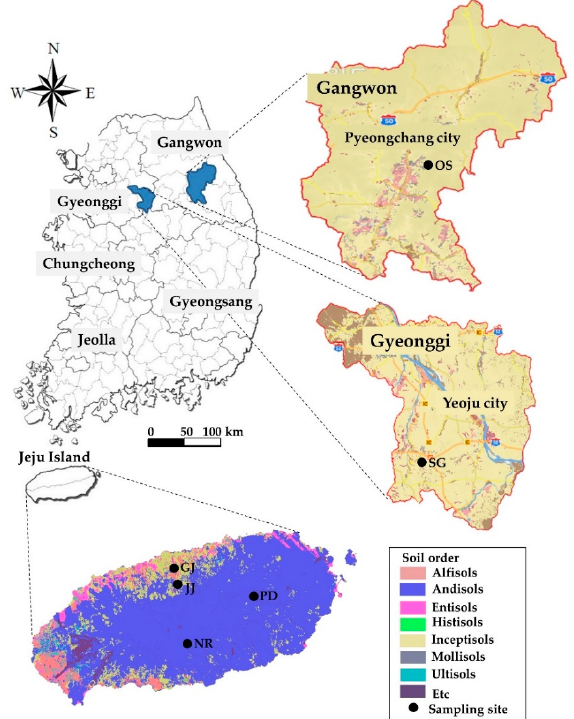
Figure 1. Map of the study area with soil sampling locations in Jeju Island [Andisols: Noro (NR) and Pyeongdae (PD), Ultisols: Jeju (JJ), Alfisols: Gangjeong (GJ)] and in Korean mainland forest soils [Inceptisols: Samgag (SG) and Oesan (OS)].